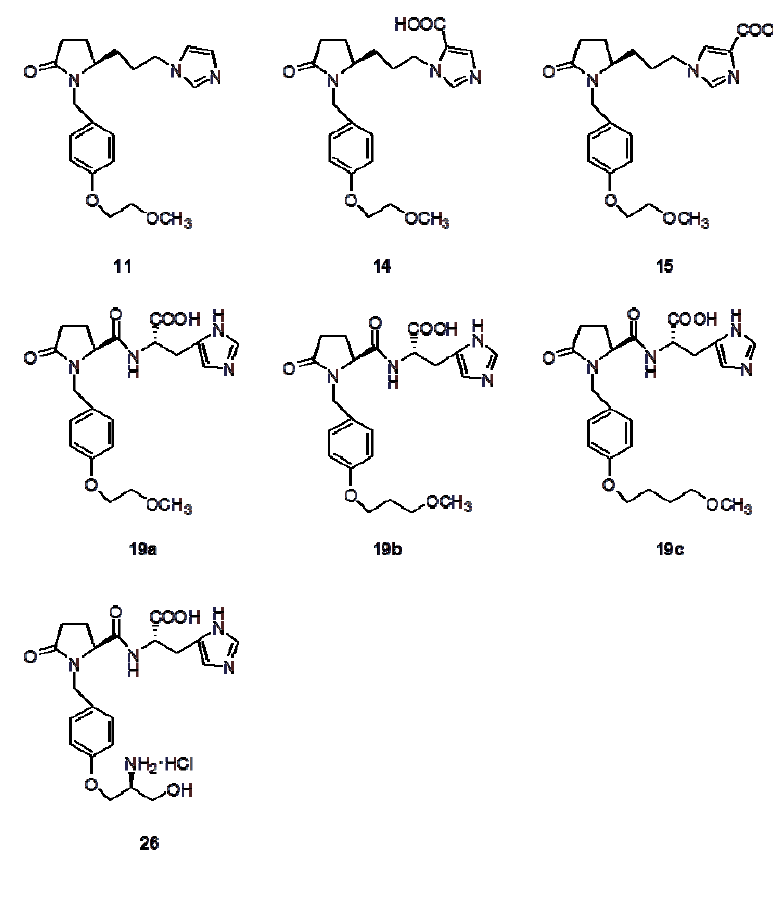
Figure 1. The structure of the new synthesized